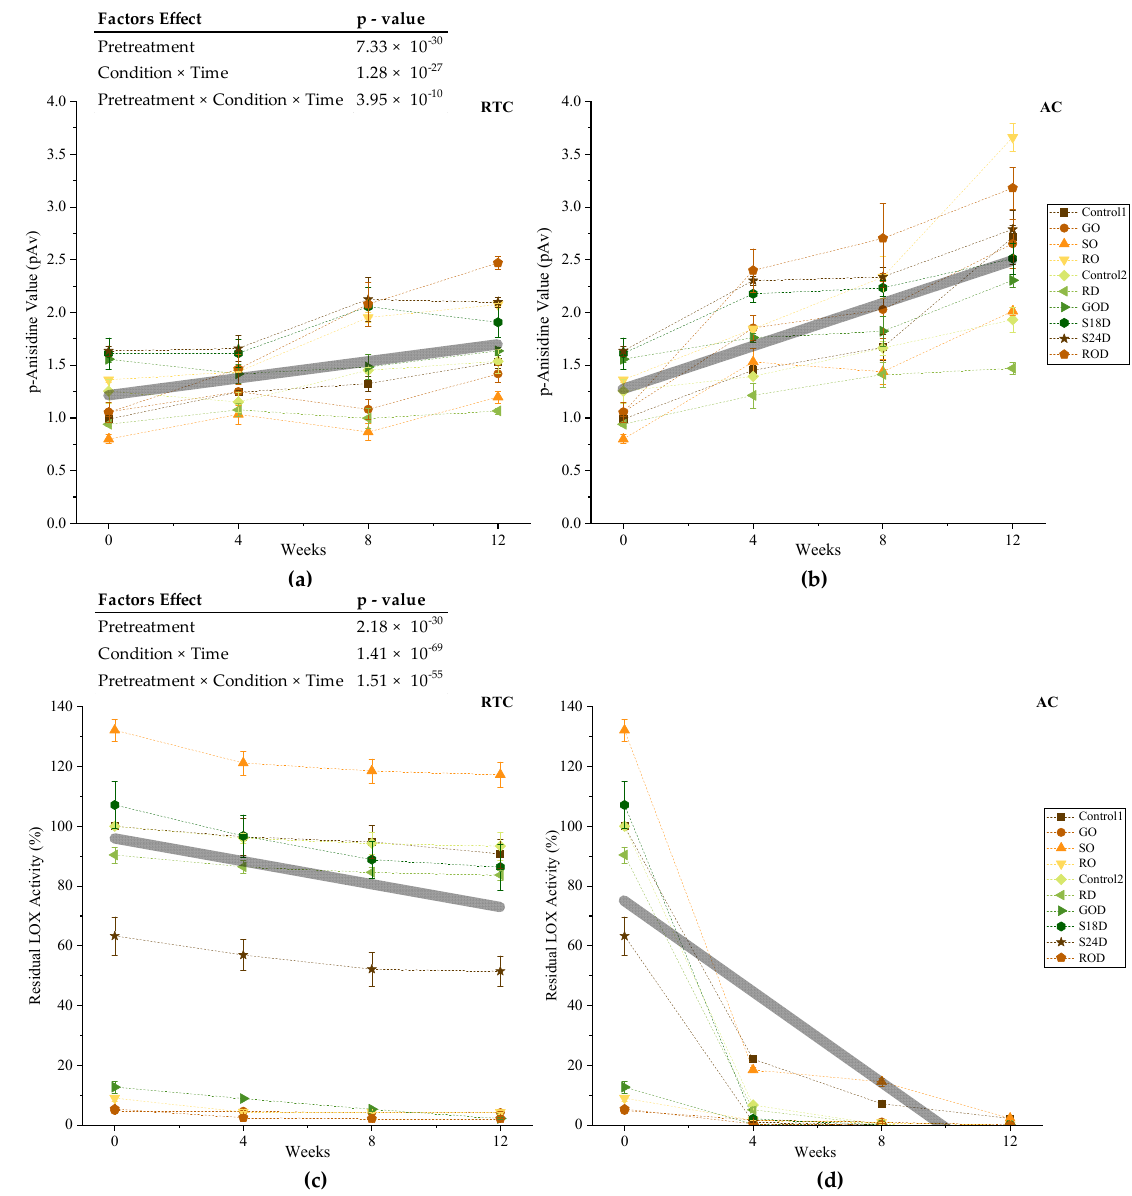
Figure 4. Changes in oxidative stability markers of FFSF kept under RTC and AC during 12-week storage. Thick gray lines represent overall pretreatment trend effect within each condition ( a ) Change in pAV under RTC; ( b ) change in pAV under AC; ( c ) change in residual LOX activity under RTC; ( d ) change in residual LOX activity under AC. (Control-1 FFSF = control sample of non-dehulled batch; germinated only FFSF = GO; soaked only FFSF = SO; roasted only = RO; Control-2 FFSF = control samples of dehulled batch; raw dehulled FFSF = RD; germinated and dehulled FFSF = GOD; soaked 18 h and dehulled FFSF = S18D; soaked 24 h and dehulled = S24 h; roasted and dehulled = ROD).